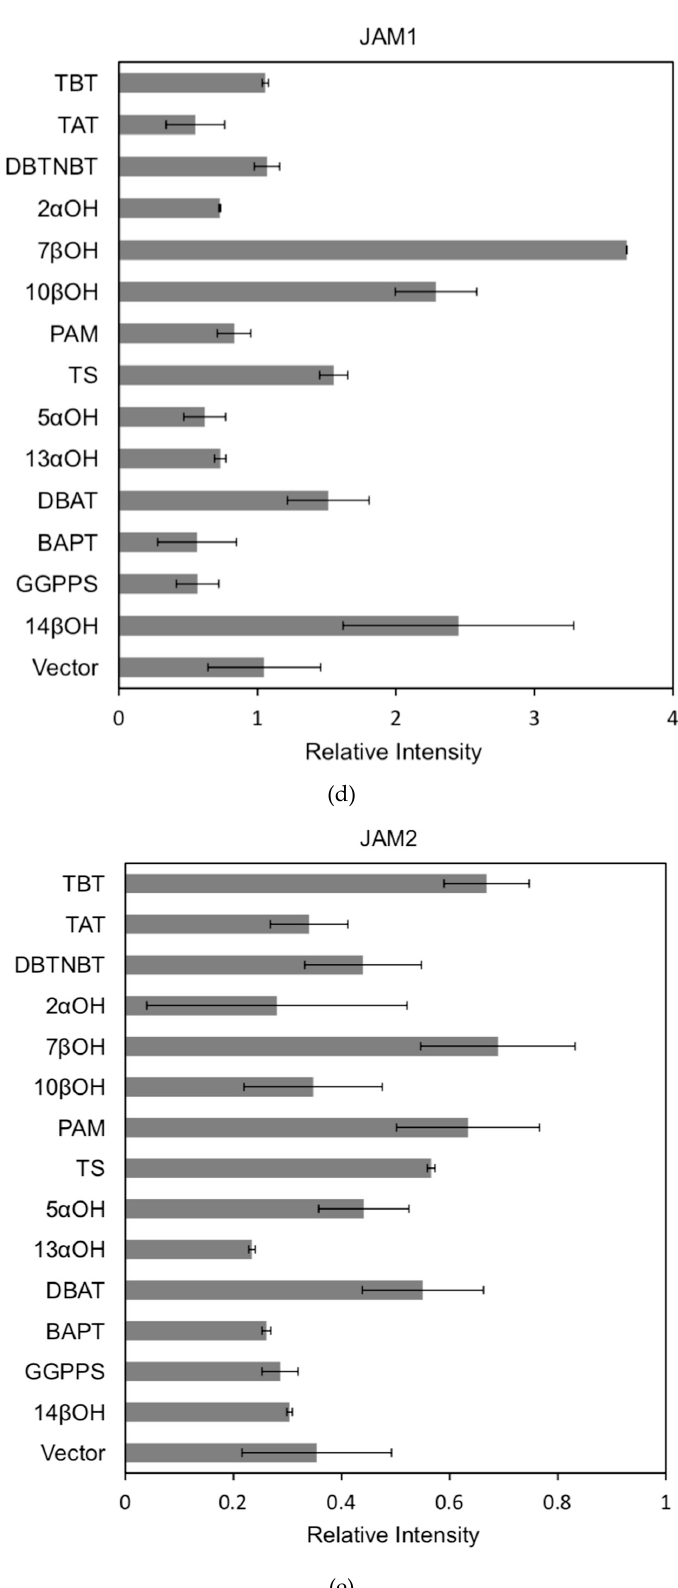
Figure 7. ( a ) transcriptional activity of MYC2 on the promoters of 14 genes known for the paclitaxel synthesis pathway (Results are presented as a LUC / REN ratio. n = 3 in all samples, error bars are SE (* p = 2 × 10 − 5 ); ( b ) transcriptional activity of MYC3 on the promoters of 14 genes with known